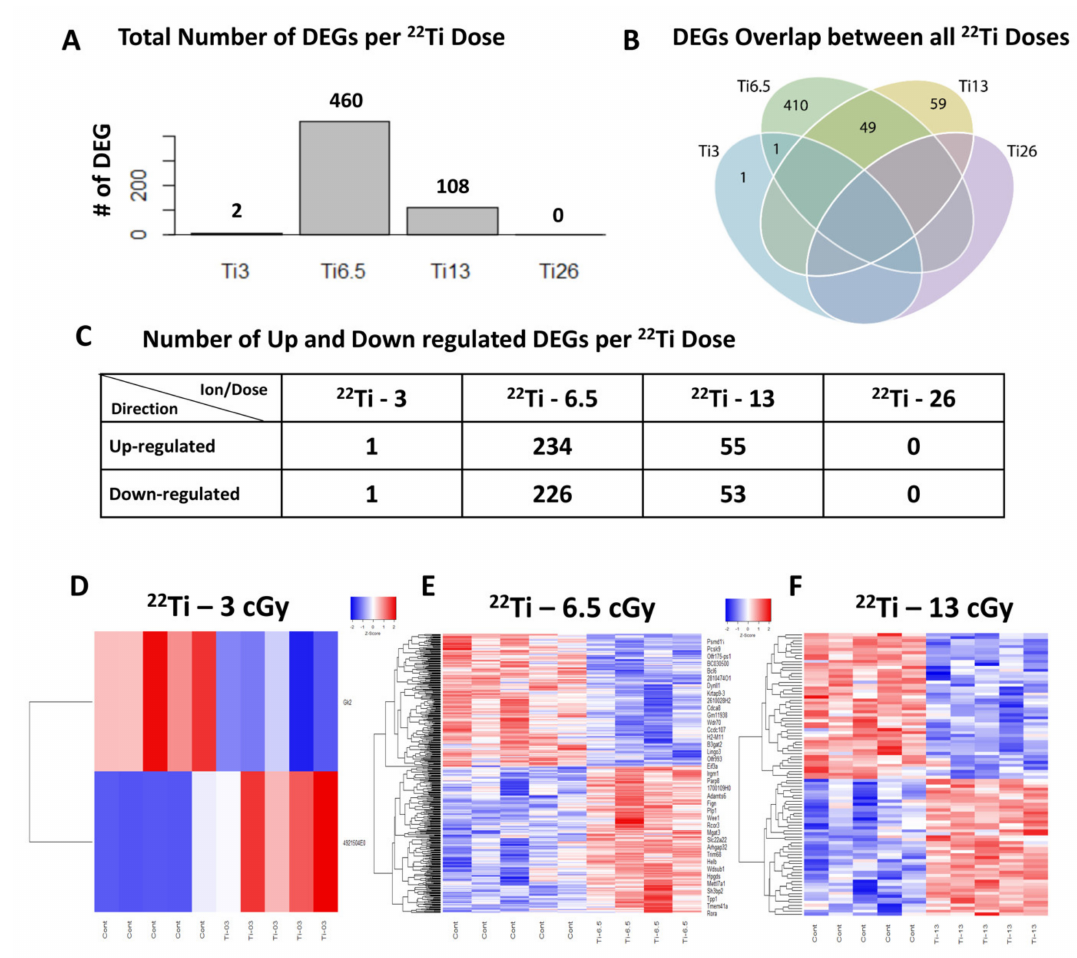
Figure 3. Different gene expression in mouse heart tissue following 22 Ti irradiation: ( A ) bar graphs showing differentially expressed genes in mouse heart tissue after exposure to different 22 Ti (Ti, titanium)-IR exposure. Colors in the diagram represent genes putatively affected by the following 22 Ti dose exposure: blue circles correspond to 3 cGy, green circles to 6.5 cGy, yellow circles to 13 cGy, and purple circles to 26 cGy. ( B ) Venn diagram depicting the number of differentially expressed genes in mouse hearts across different doses of Ti radiation exposure. Colors in the diagram represent genes putatively affected by the following Ti dose exposure: blue circles correspond to 3 cGy, green circles to 6.5 cGy, yellow circles to 13 cGy, and purple circles to 26 cGy. ( C ) Table depicting the number of up- and downregulated genes after exposure to different 22 Ti-IR doses in the heart tissue and ( D – F ) heat maps showing differentially expressed genes at different 22 Ti-IR doses. Relative expression values are indicated on the color key and increase in value from blue to red ( n =